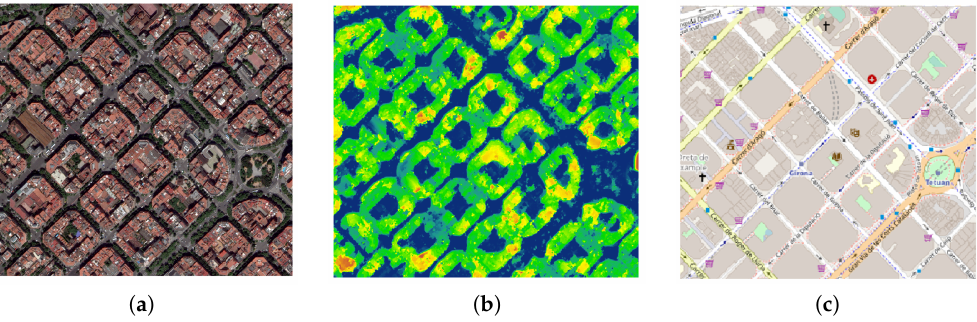
Figure 10. Barcelona street network type (grid pattern with streets that intersect at right angles); detailed view of ( a ) WV-3 forward image, ( b ) DSM 0.30 m resolution with filled occlusions by interpolation, and ( c ) OSM street view.